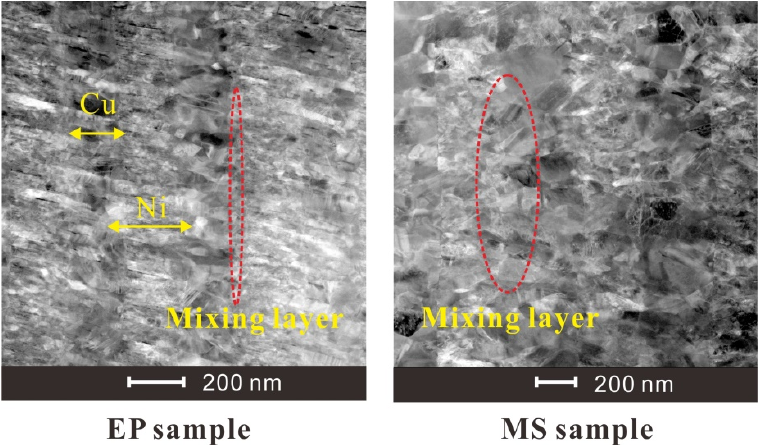
Figure 4. TEM diagram of the foil section of the multilayer bridge (side view, scale bar: 200 nm).